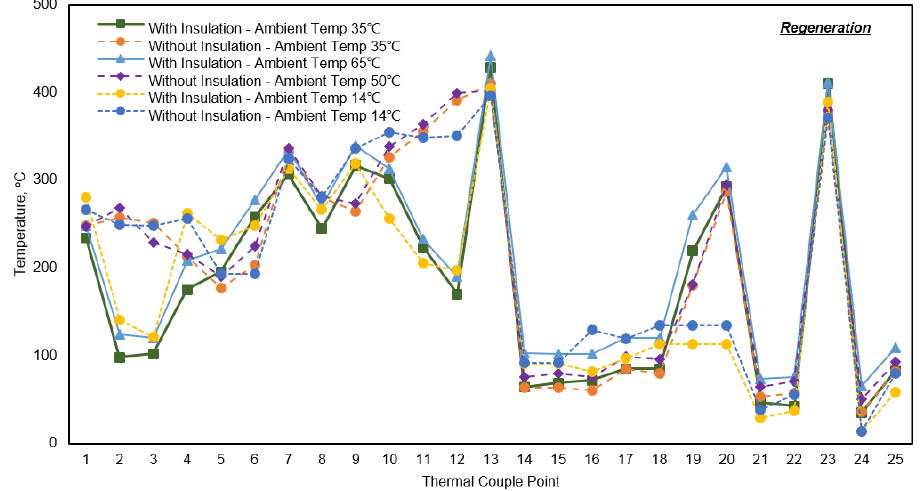
Figure 6. Max temperature at each thermal couple point—regeneration. Catalysts 2020 , 10 , x FOR PEER REVIEW